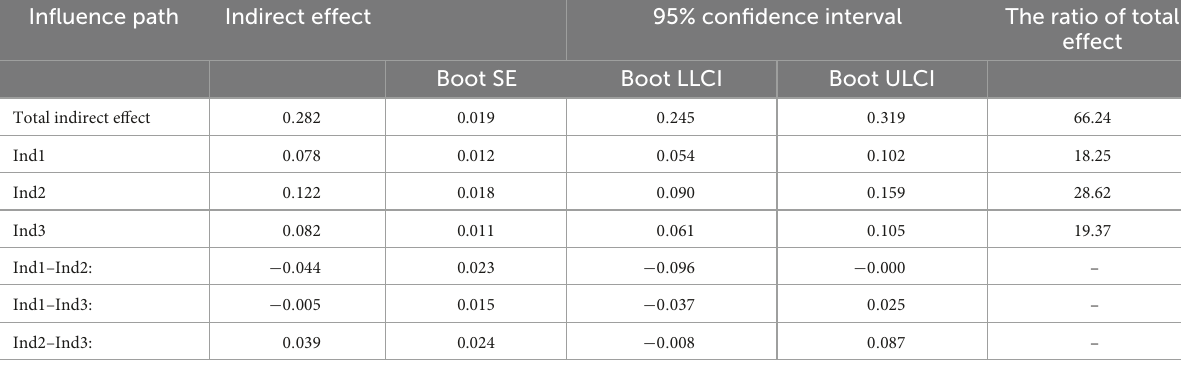
TABLE 4 Bootstrap analysis of significance test of intermediary